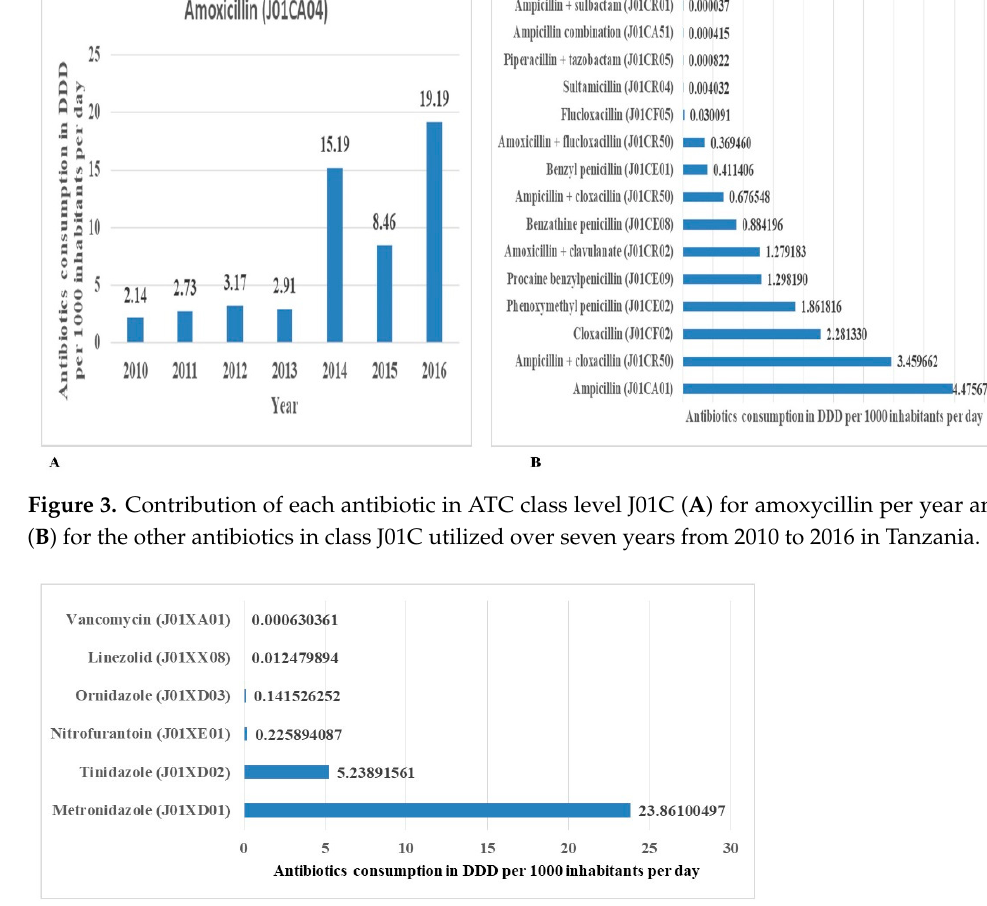
Figure 4. Contribution of each antibiotic in ATC class level J01X for the other antibiotics utilized over seven years from 2010 to 2016 in Tanzania.